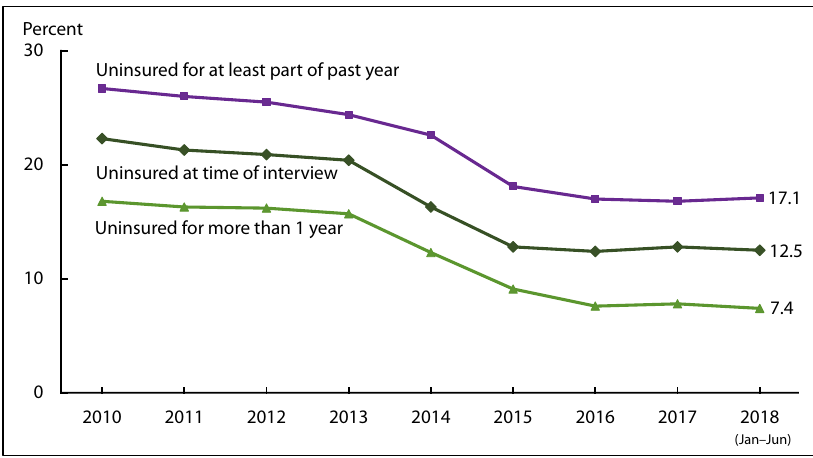
Figure 7. Percentage of adults aged 18 – 64 without health insurance, by three measures of uninsurance: United States, 2010–June